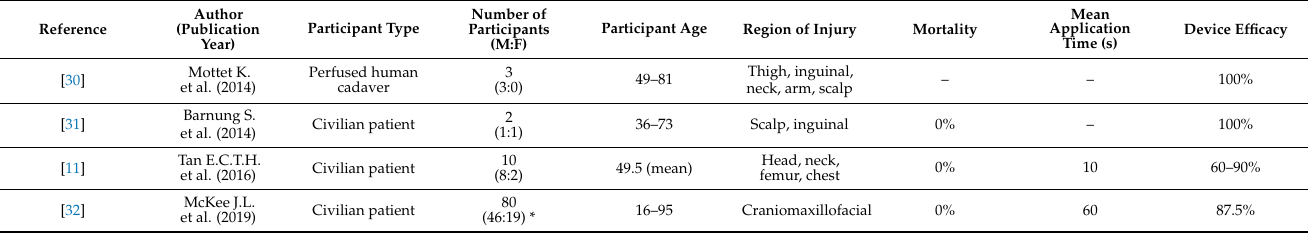
Table 5. Summary of iTClamp TM study characteristics, patient demographics, and outcome measure